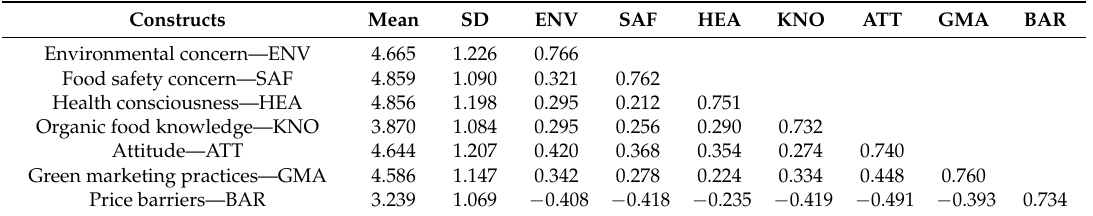
Table 3. Descriptive statistics and discriminant validity.